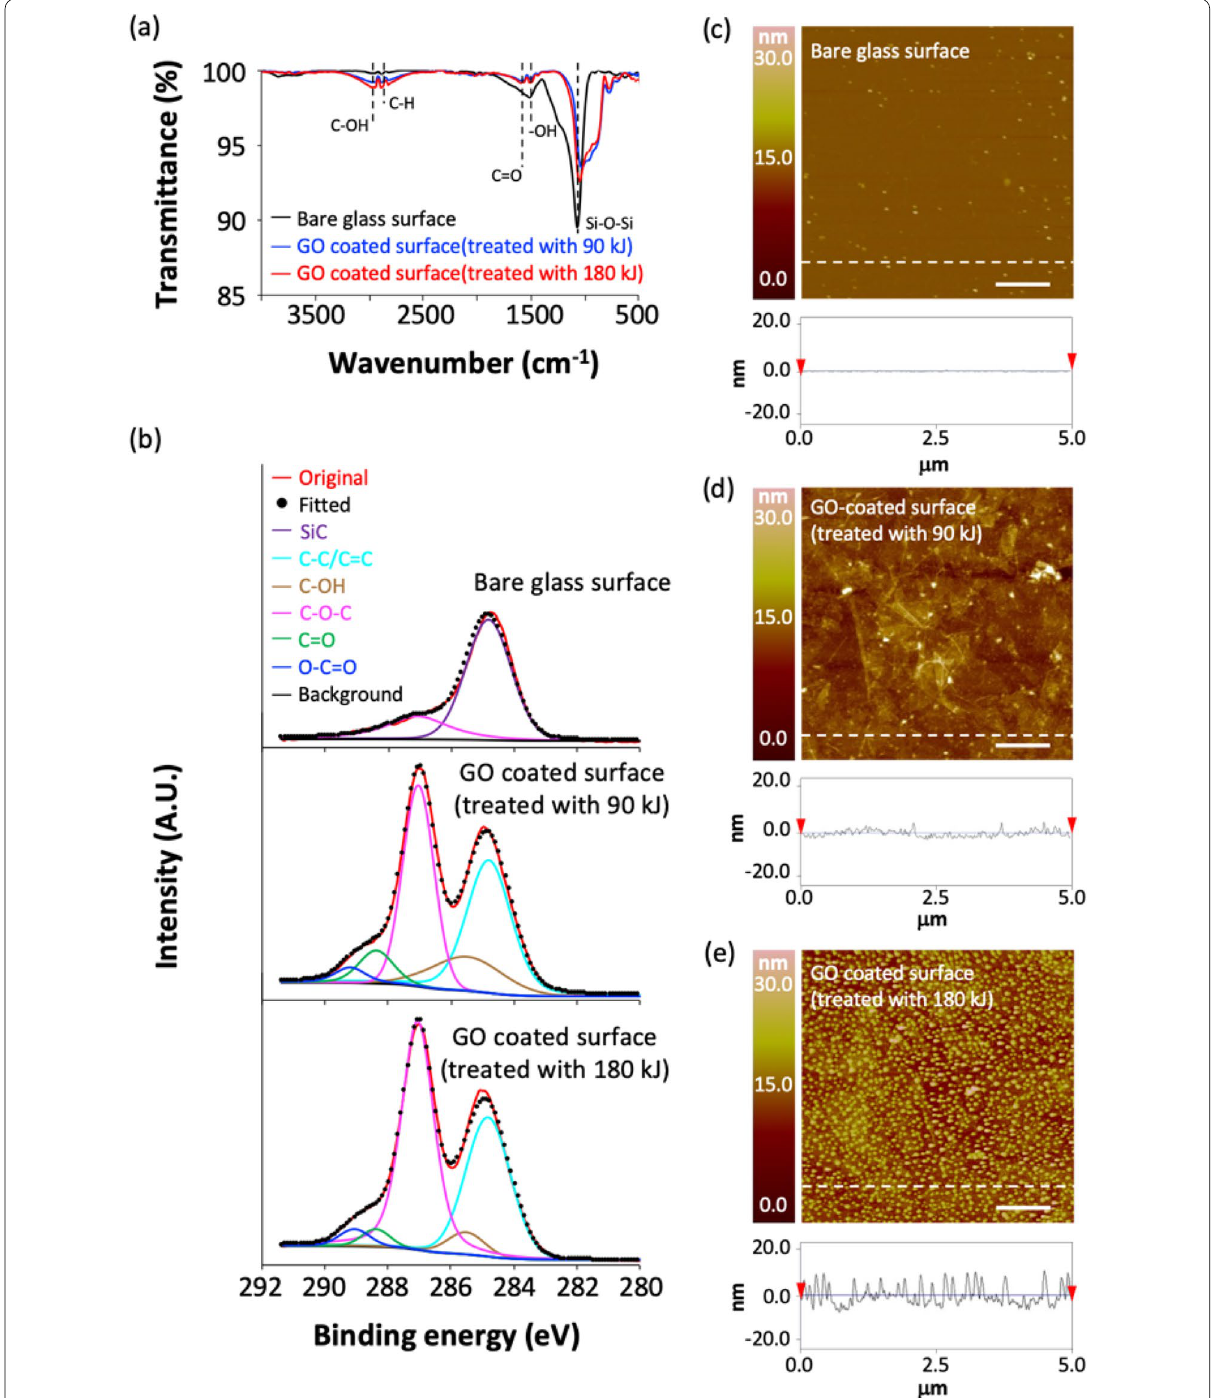
Fig. 2 Analysis of the GO‑coated surface by a FTIR spectra, and b XPS spectrum of the carbon region. AFM image of c bare glass surface, d GO‑coated surface treated with 90 kJ, and e GO‑coated surface treated with 180 kJ. (Scale